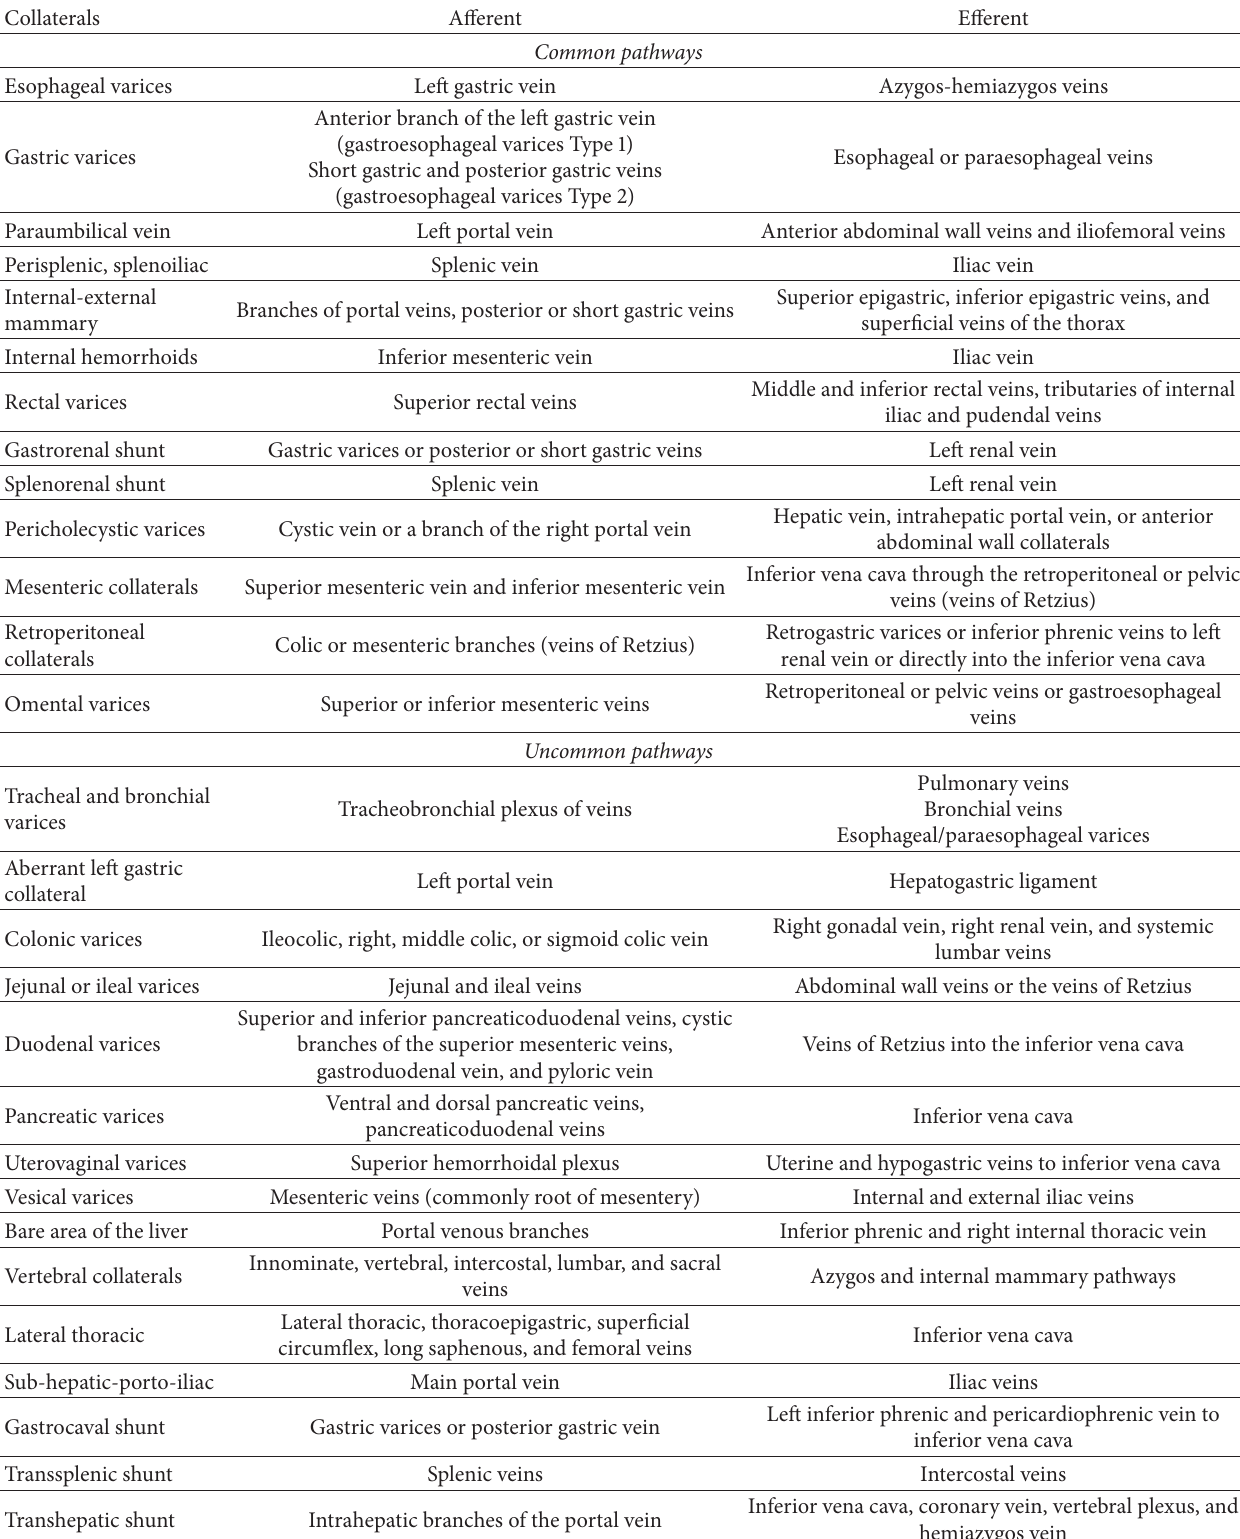
Table 1: Common portosystemic collaterals